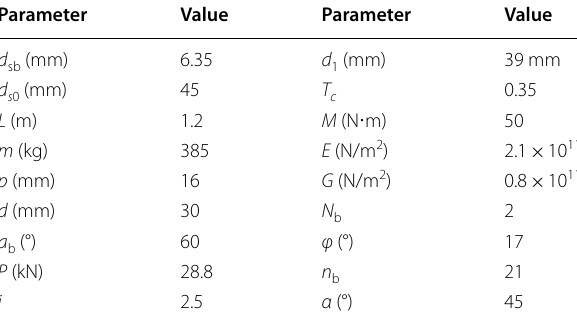
Table 1 Simulation parameters Parameter